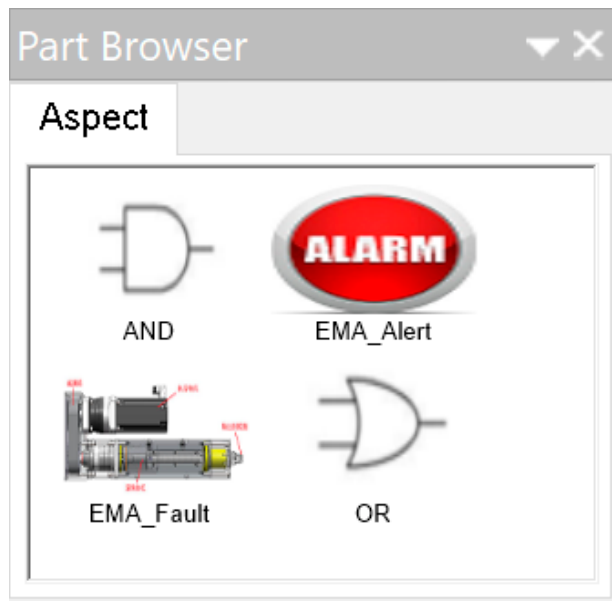
Figure A2. The basic model of EMA in GME.